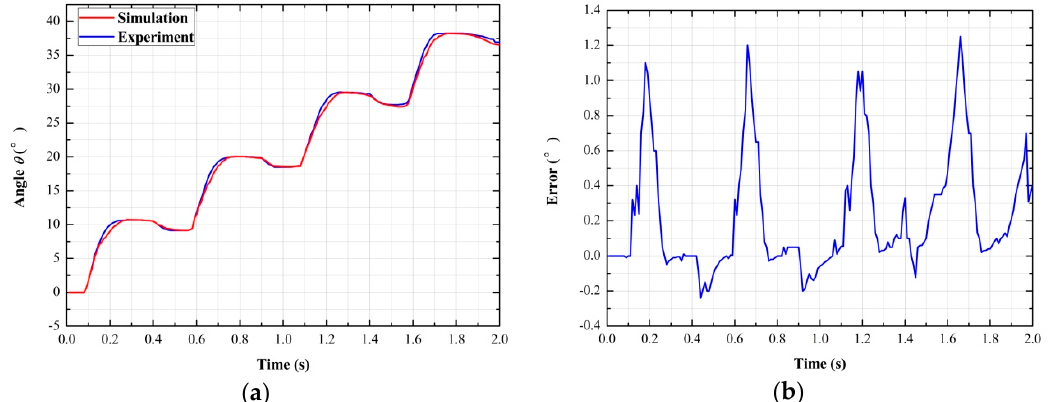
Figure 24. Rotation angle curve and its error curve: ( a ) Rotation angle curve; ( b ) Error.